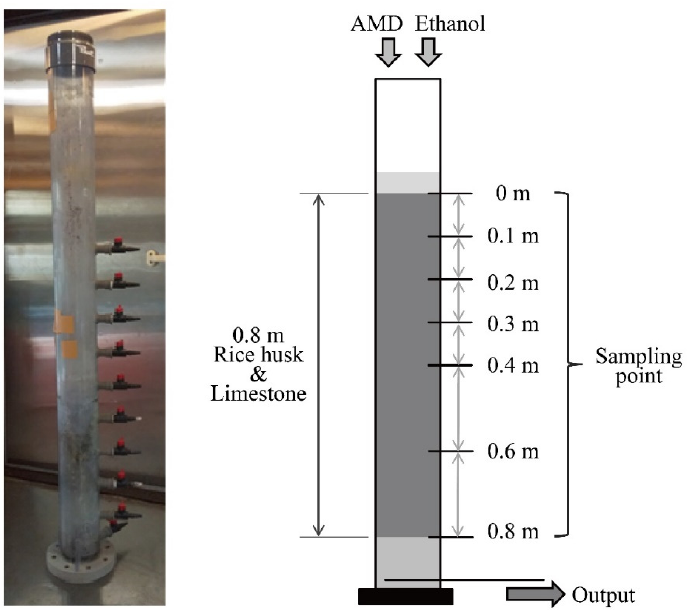
Figure 1. A picture and configuration of the sulfate-reducing column reactor.